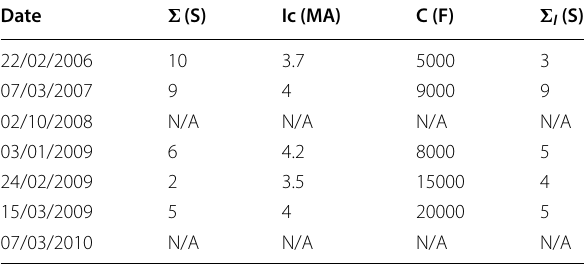
Table 2 WINDMI model parameters obtained when tuned to auroral electrojet activity given by AL/SML